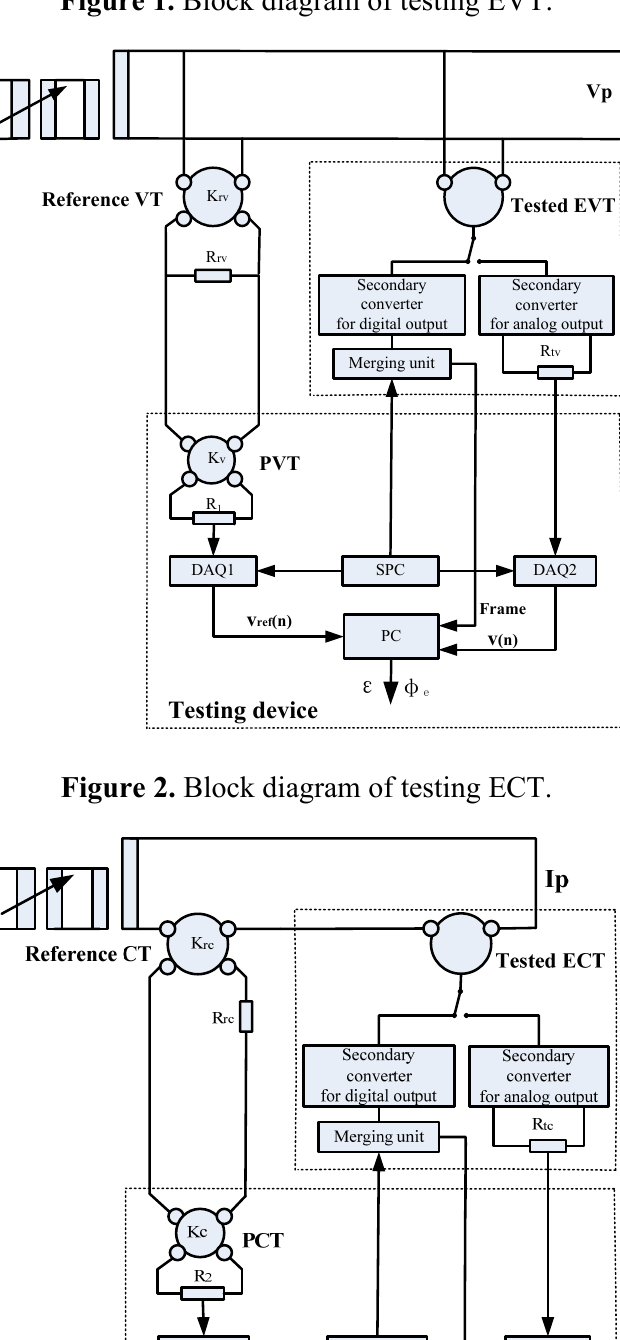
Figure 1. Block diagram of testing EVT.